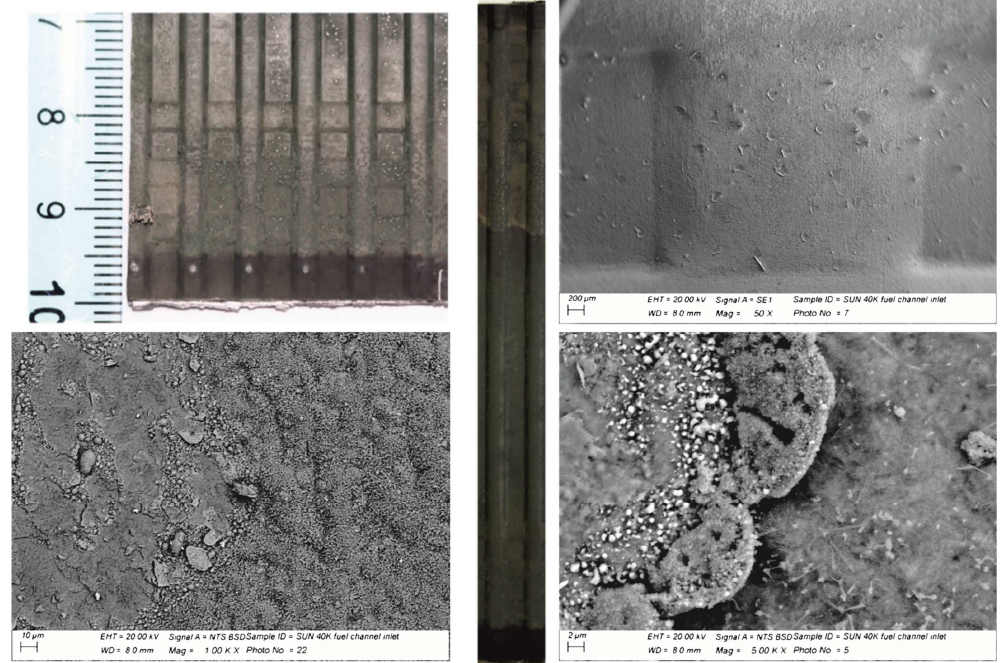
Figure 6. A general and detailed view of an MIC surface at the fuel side. The green spots visible at the macroscopic level correspond to the footprint of the Ni contact layer between the metal substrate and the anode of the cell. Energies 2022 , 15 , x FOR PEER REVIEW The SEM observations allowed for the interpretation of such spots as the zones of contact between the Ni foam and the interconnect (Figure 6). The spots appeared as a grey, nearly metallic color in the remaining half of the metal plate (i.e., from the center to the outlet). This highlights the intimate bond between the metal substrate and the Ni foam. The complete characterization of the surface highlighted a wide variety of oxidation fea- tures from very small crystals forming a uniform layer of thermally grown oxide to needle like oxides surrounded by amorphous phases of various shapes (Figure 7).